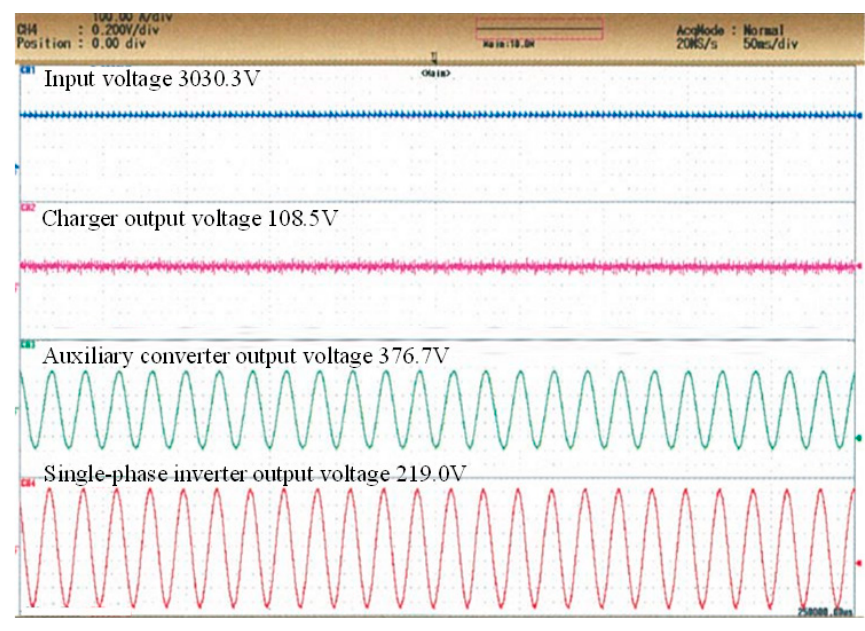
Figure 22. Results under rated load conditions. Table 6. Di ff erence between simulation and experimental data under rated